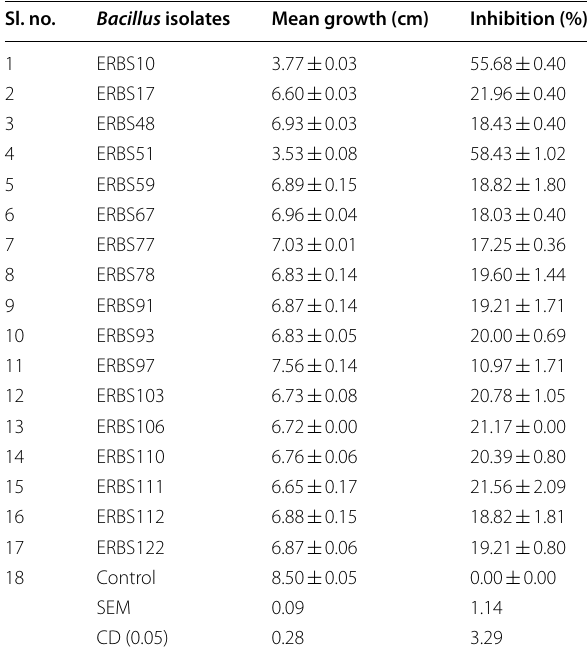
Values are the means (